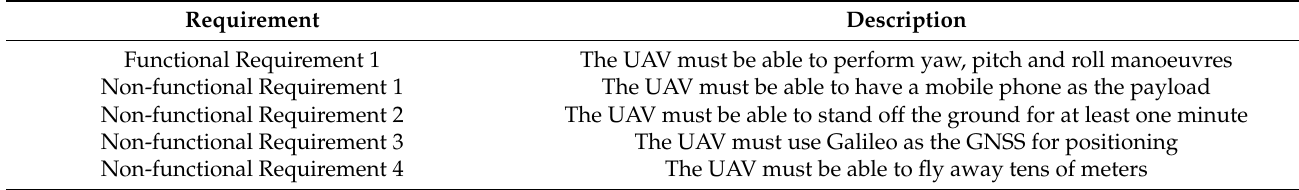
Table 4. Requirements for the